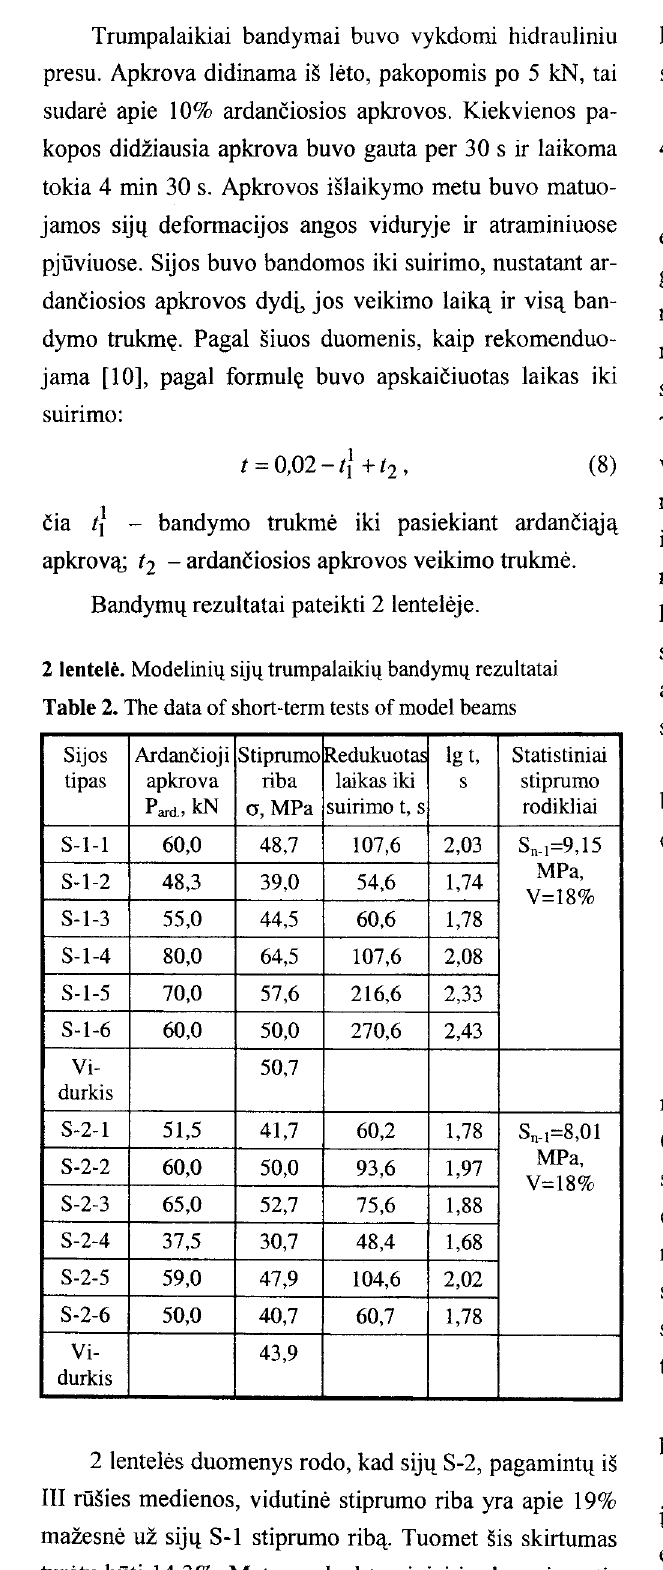
III rusies medienos, vidutine stiprumo riba yra apie 19% mazesne uz sijll S-1 stiprumo rib<t. Tuomet sis skirtumas turetll biiti 14,3%. Matome, kad teoriniai ir eksperimenti niai duomenys yra artimi. Reikia pamineti, kad sijl.! S-2 vidutine ir minimali stiprumo riba yra didesne uz II rusies medienos pjaustinill trumpalaik~ ir normin~ stiprumo